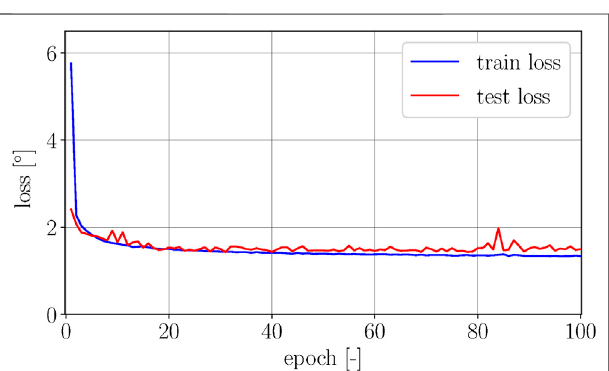
FIGURE7| The fi gureshowsthesquarerootofthetrainingandtestloss over 100 epochs. The gap between train and test loss is relatively small, showingslightindicationsofover fi ttingforhigherepochs.Thelowesttesterror is achieved in epoch 31 with a corresponding error of 1 . 43 + .